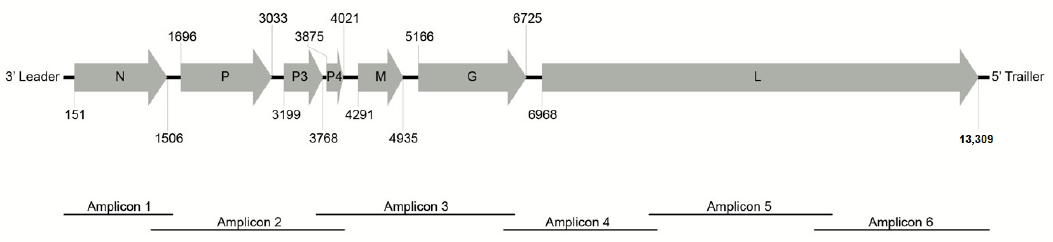
Figure 5. Genome organization of BaCV-Luz. Canonical genes encoding [N] nucleoprotein, [P] phosphoprotein, [M] matrix protein, [G] glycoprotein and [L] RNA-dependent RNA polymerase (RdRp), and non-canonical [P3] and [P4]. Each ORF is represented by a gray arrow with the first and last nucleotide positions depicted. The complete genome (13,467 nts) was recovered by RT-PCR of six overlapping amplicons.